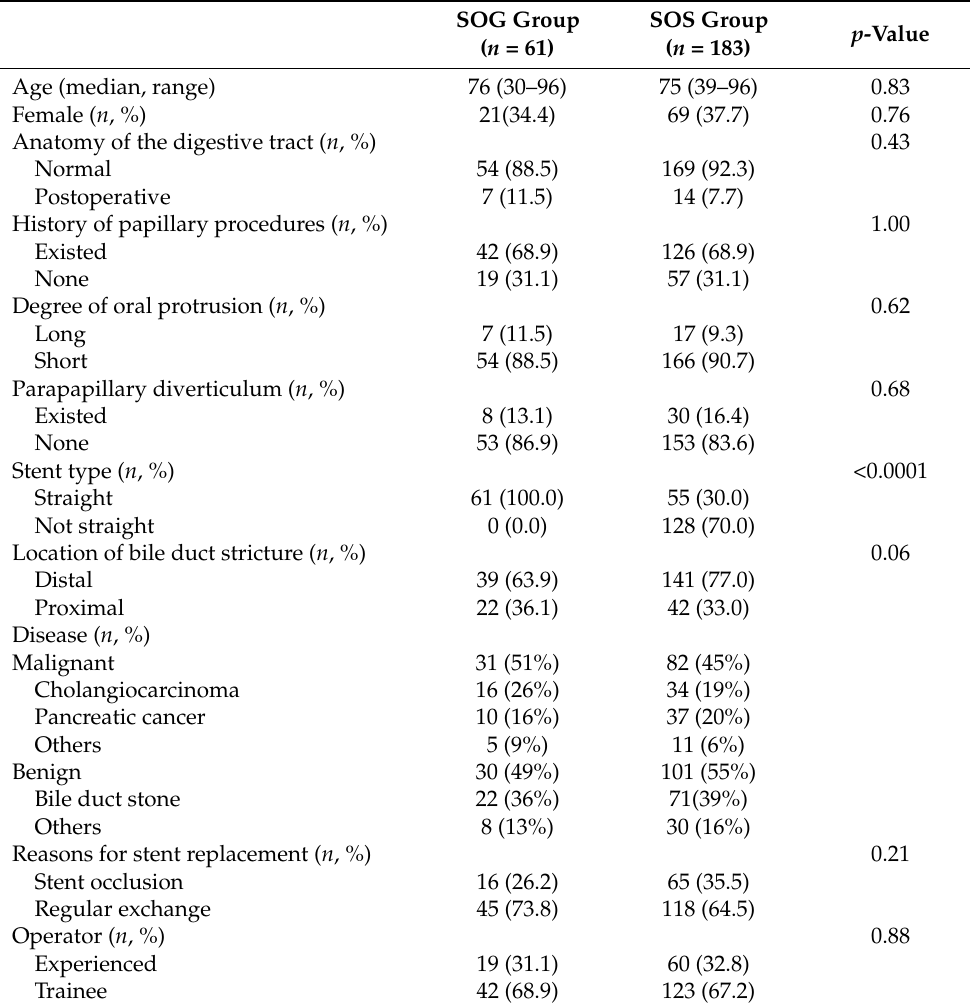
Table 1. Baseline